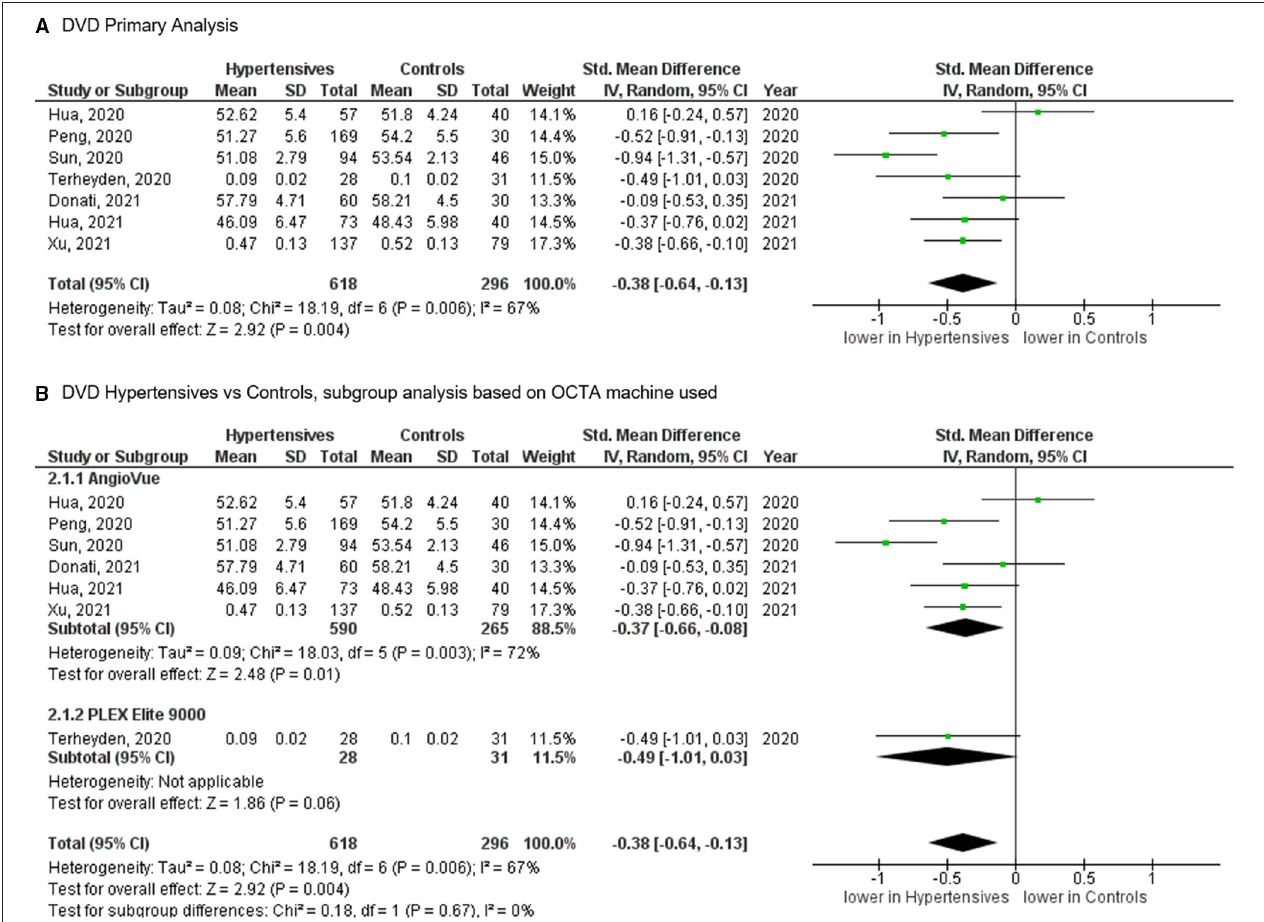
FIGURE 4 | (A) Meta-analysis of deep vascular density (DVD; SMD) and (B) DVD subgroup analysis based on OCTA devices for patients with systemic hypertension vs. controls. Mean and standard deviation (SD) are included, with 95% confidence intervals (CIs), heterogeneity scores, and overall effect in an inverse variance (IV) random effects model. The green square size represents the weight attributed to each study based on relative sample